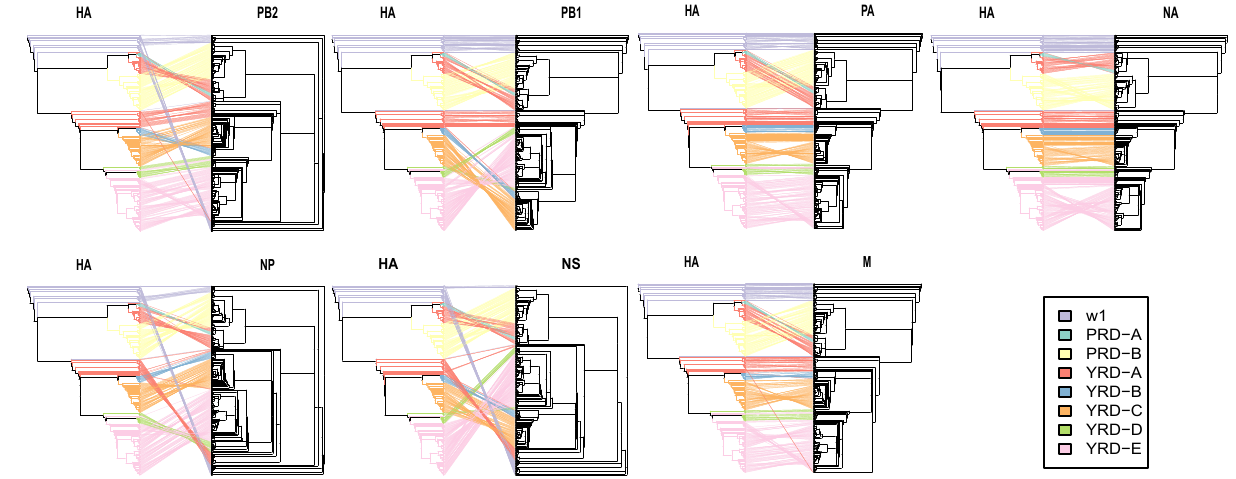
Figure 7. Evolutionary relationships of each gene segment with HA. Incongruence phylogenetic analysis shows interclade reassortment between the HA segment and seven additional genes (NA, PB2, PB1, PA, NP, and M). Equivalent strains connect across the trees. Tips and connecting lines are colored according to the HA clusters. Unentanglement is used to minimize crossings of the hybridization network between the paired trees. The values are determined by the degree of inter- segment